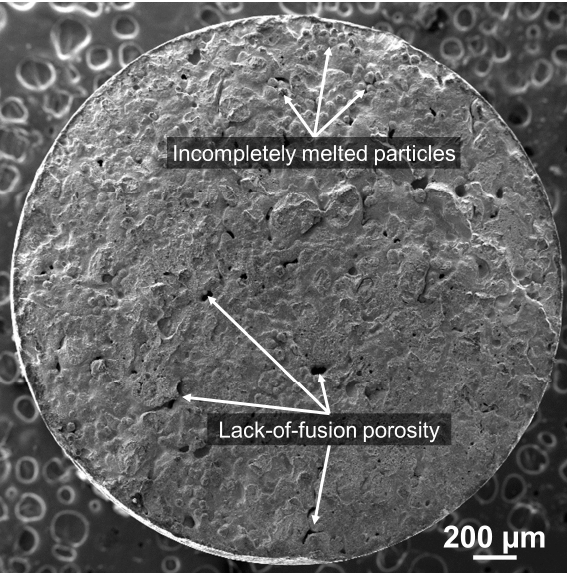
Figure 4. Overall fracture morphology of specimen #3 with insufficiently melted powder particles and porosity.